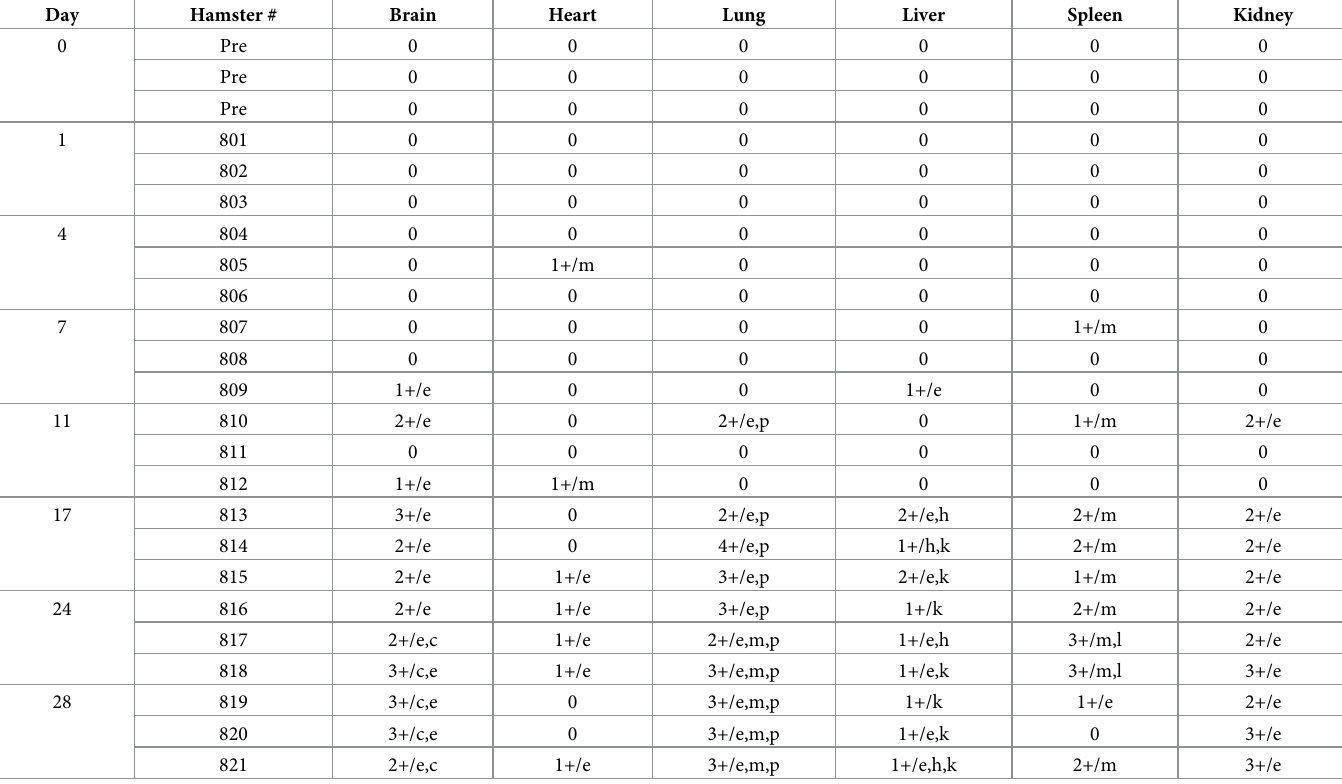
Table 2. Pathology scores for HTNV IM infected